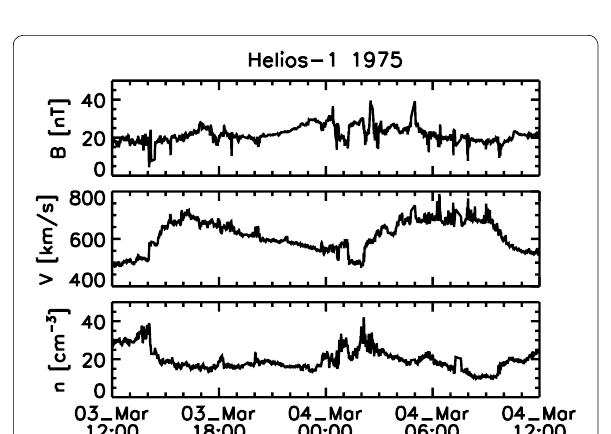
Fig. 1 Time series plots of the magnetic field magnitude, flow velocity magnitude (for protons), and proton number density from the Helios-1 spacecraft measurement in the inner heliosphere (at a radial distance of about 0.4 AU from the Sun) on March 3–4,